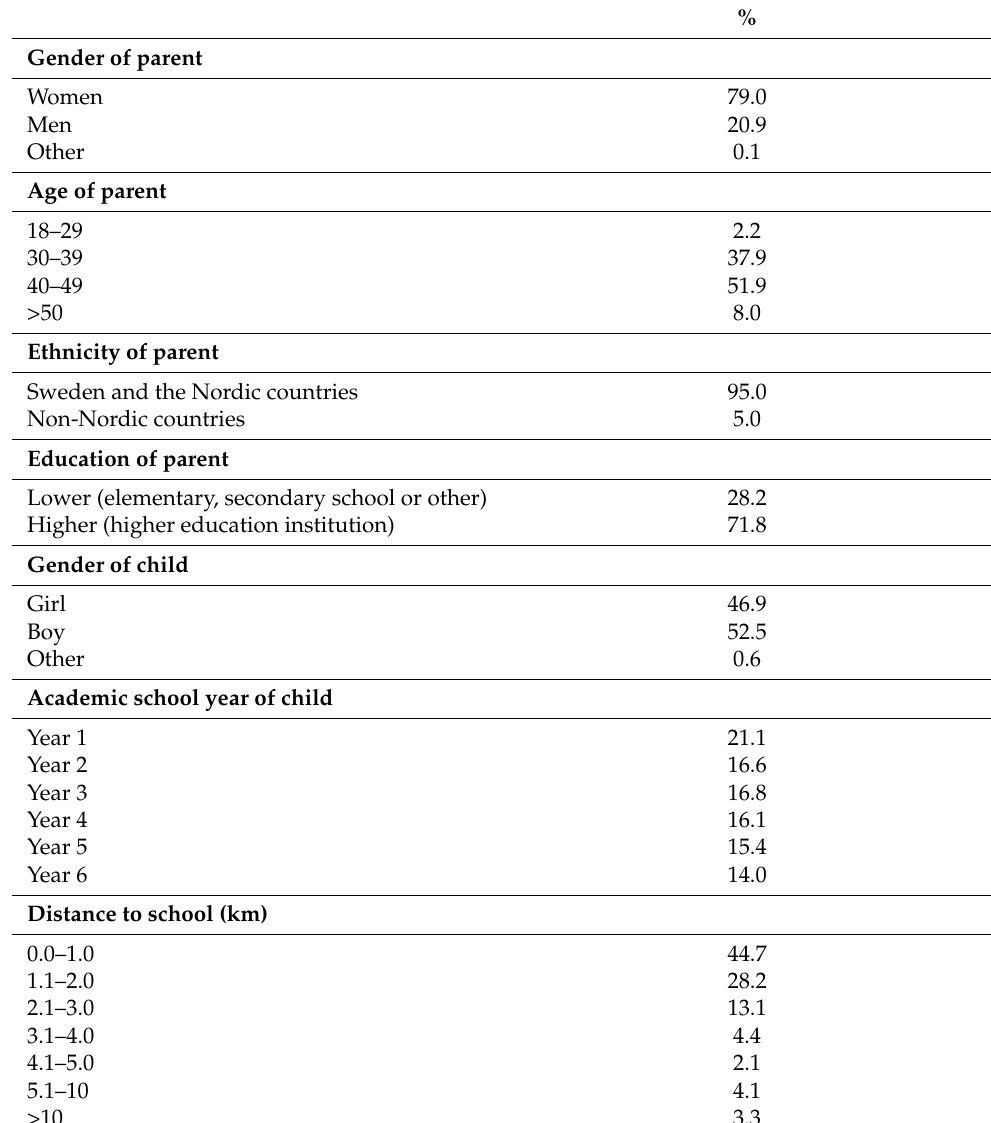
Table 1. Socio-economic and demographic background characteristics of the participants ( n =